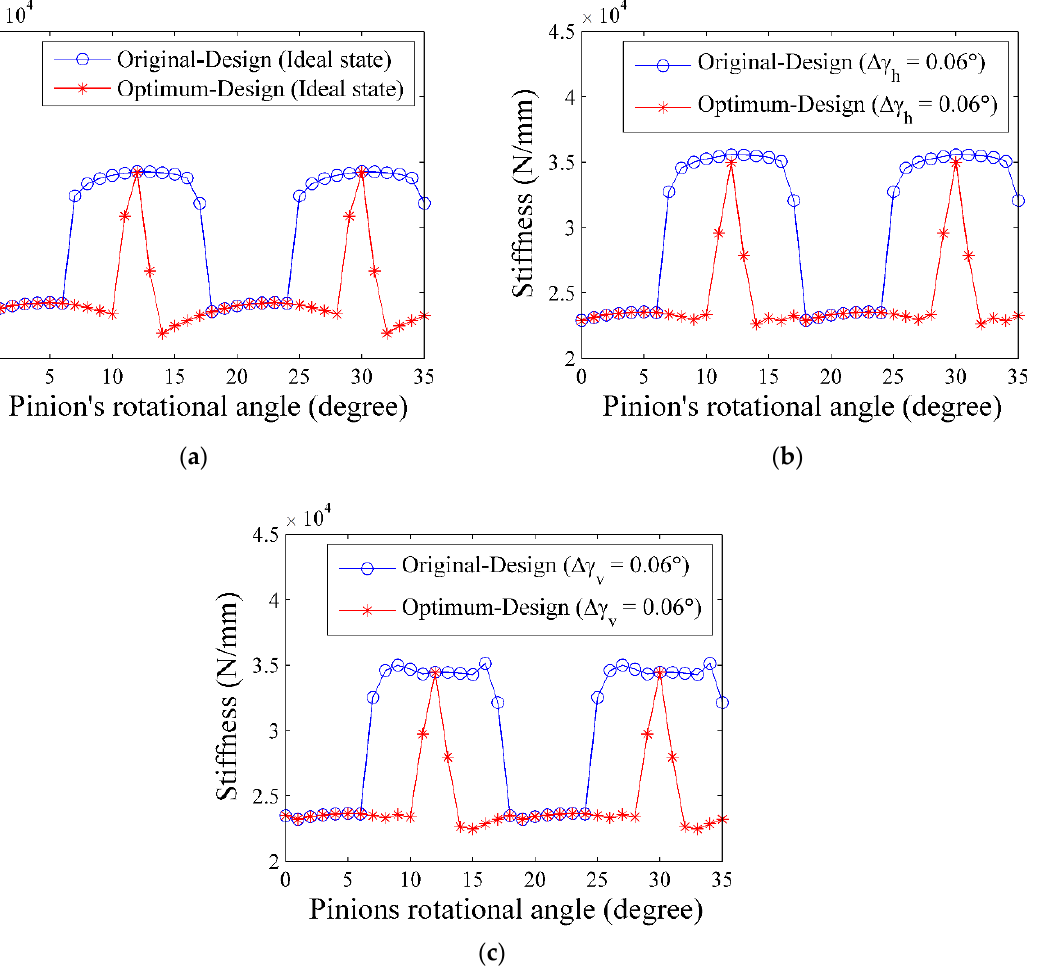
Figure 11. Mesh stiffness: ( a ) ideal state; ( b ) horizontal axial misalignment of 0.06°; ( c ) vertical axial misalignment of 0.06°.